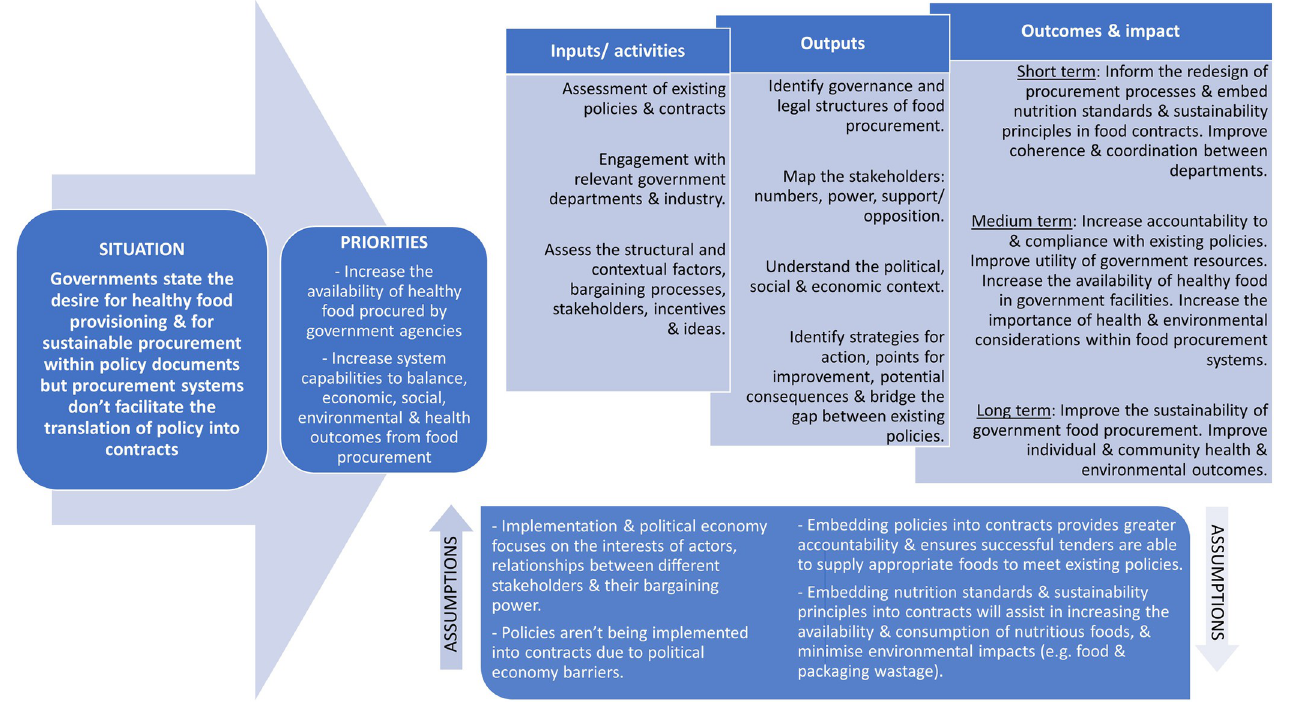
Fig 2. Logic model for embedding nutrition standards and sustainability principles into food procurement contracts.